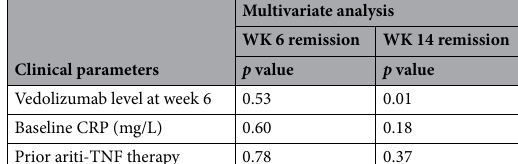
Clinical parameters